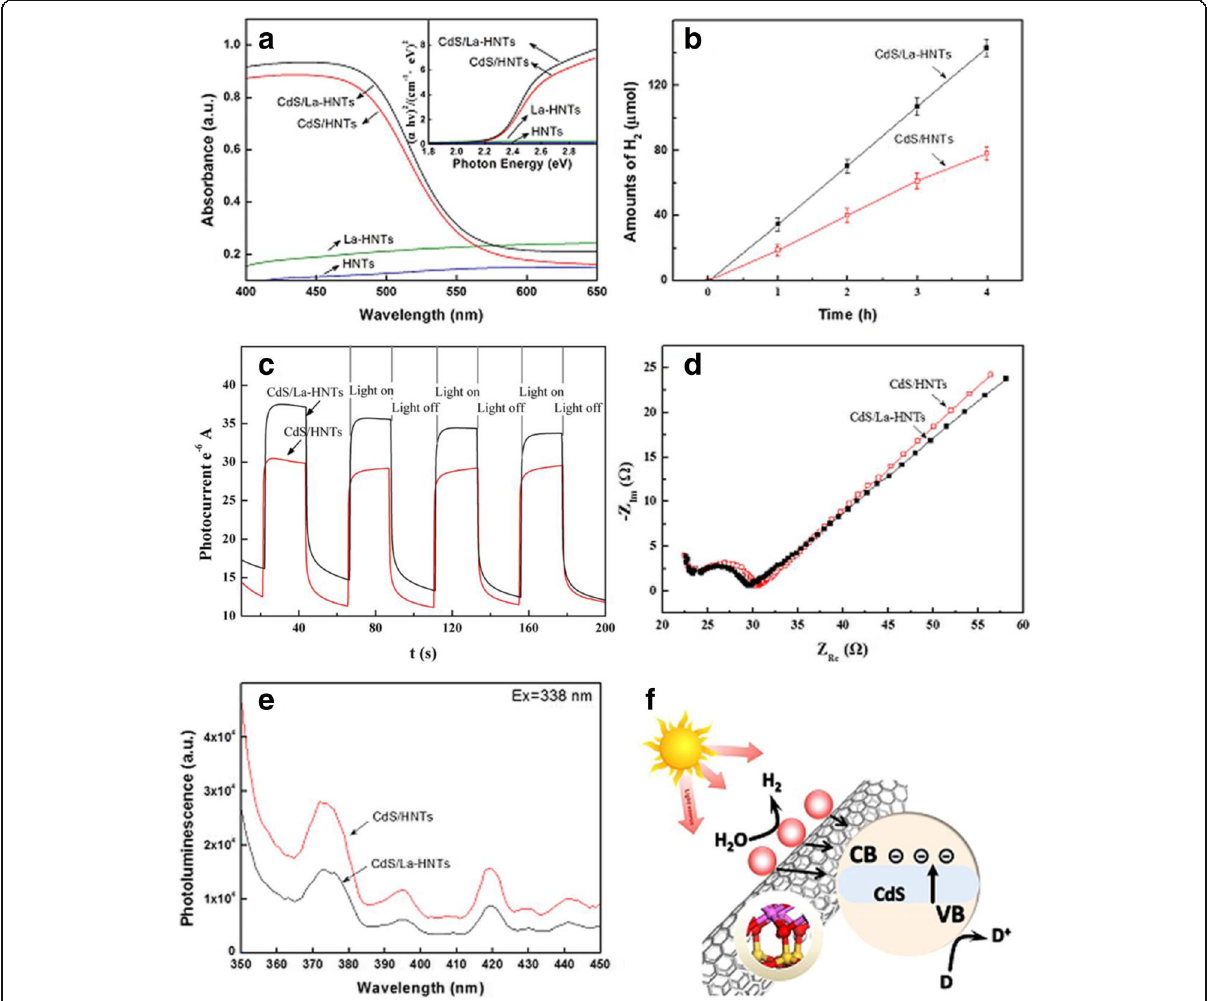
Fig. 4 a UV-vis spectra, b photocatalytic hydrogen curve, c the transient photocurrent responses, d Nyquist impedance plots, e PL spectra, and f corresponding catalytic schematic of CdS/HNT and CdS/La-HNT